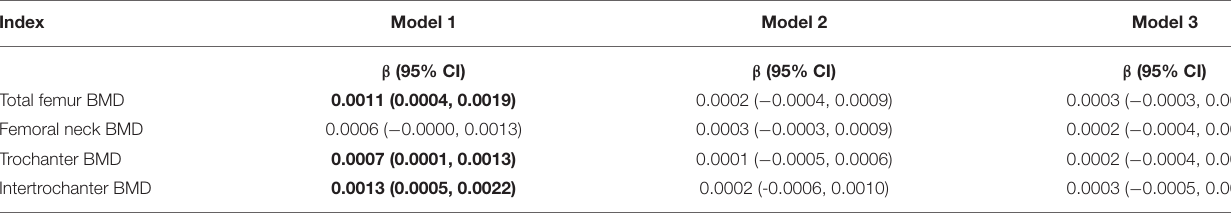
TABLE 2 | Association between dietary fiber intake and femoral BMD.